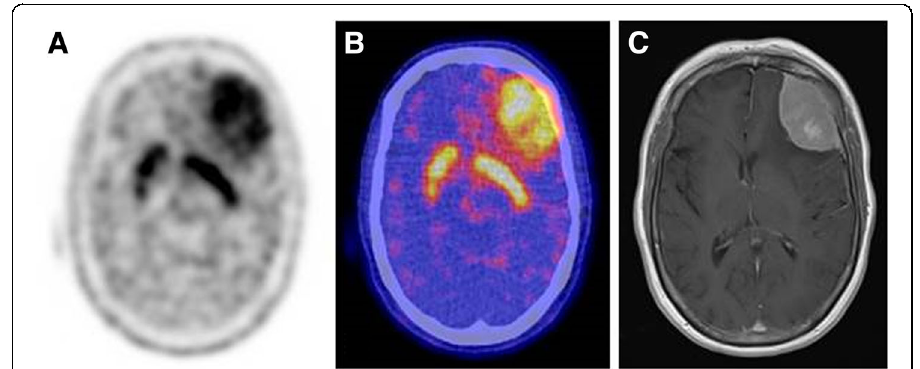
Fig. 2 The meningeoma on the left frontal region showed elevated 18 F-FDOPA uptake ( a , b ), confirmed on MRI ( c ). Physiological 18 F-FDOPA uptake in the